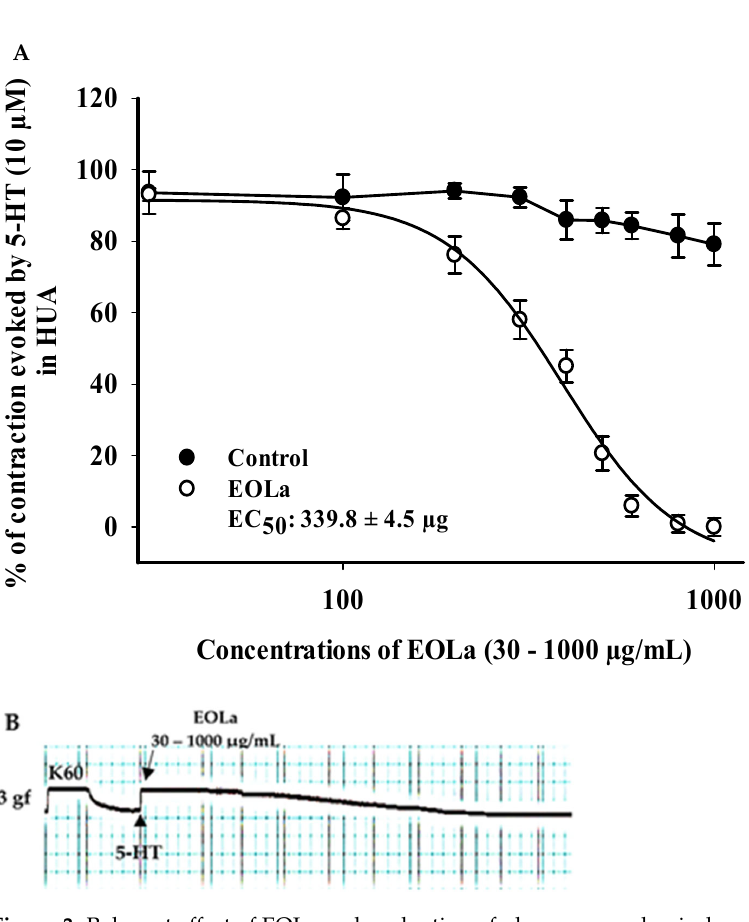
Figure 5. Relaxant effect of EOLa (30–600 μ g/mL) and evaluation of pharmacomechanical coupling by HIST (10 μ M) in HUA. Concentration–response bar graph for the effect of EOLa on contractions induced by histamine in HUA. Values are expressed as the mean ± SEM; n = 6 ( p < 0.01, one ‐ way ANOVA).